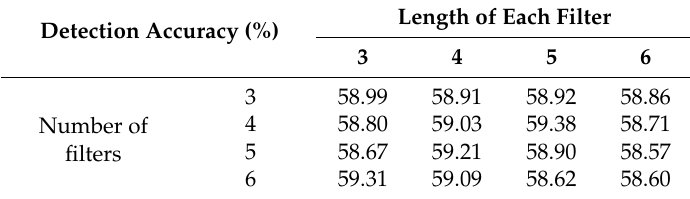
Table 7. Detection results of changing the number of filters and length of each filter with Dataset KTU.